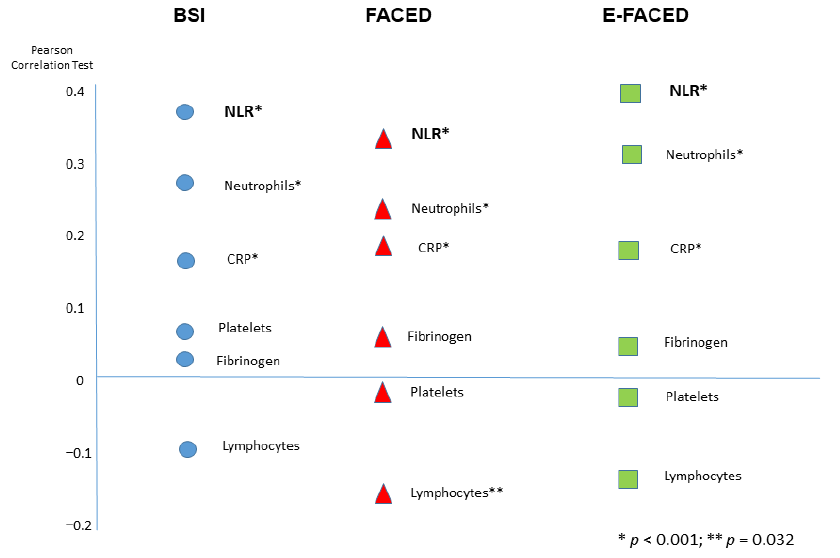
Figure 1. Correlations between different systemic inflammation markers (including the neutrophil- to-lymphocyte ratio) and severity scales in bronchiectasis. BSI: Bronchiectasis Severity Index, NLR: neutrophil-to-lymphocyte ratio; CRP. C-reactive protein.